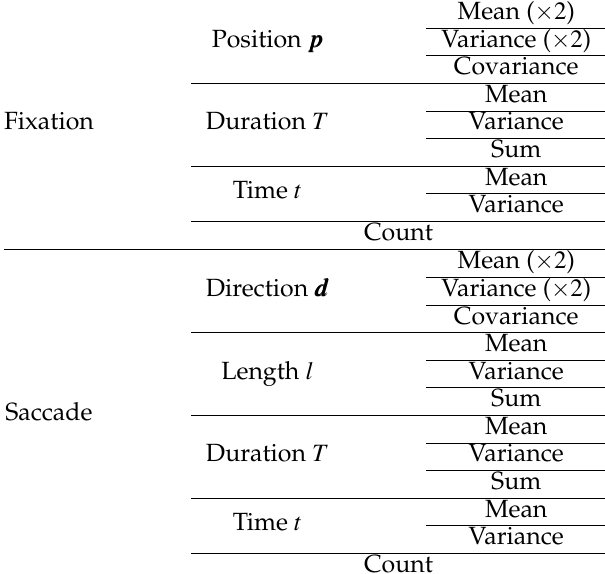
Combinations of event attributes and statistical operations used to compute features for our